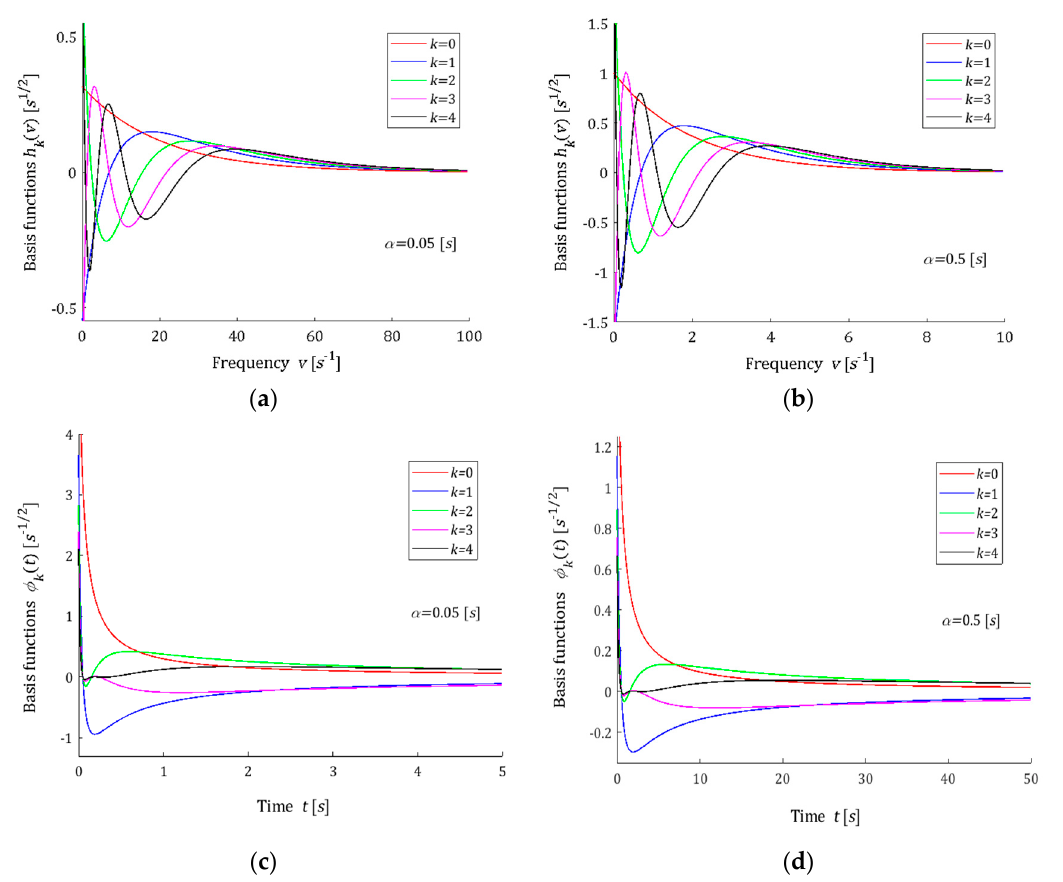
Figure 1. Basis functions h k ( v ) (31) and φ k ( t ) (32) of the Legendre model for two time-scaling factors α : ( a ) h k ( v ) , α = 0.05 [ s ] ; ( b ) h k ( v ) , α = 0.5 [ s ] ; ( c ) φ k ( t ) , α = 0.05 [ s ] ; ( d ) φ k ( t ) , α = 0.5 [ s ] ; k = 0,1,2,3,4 .